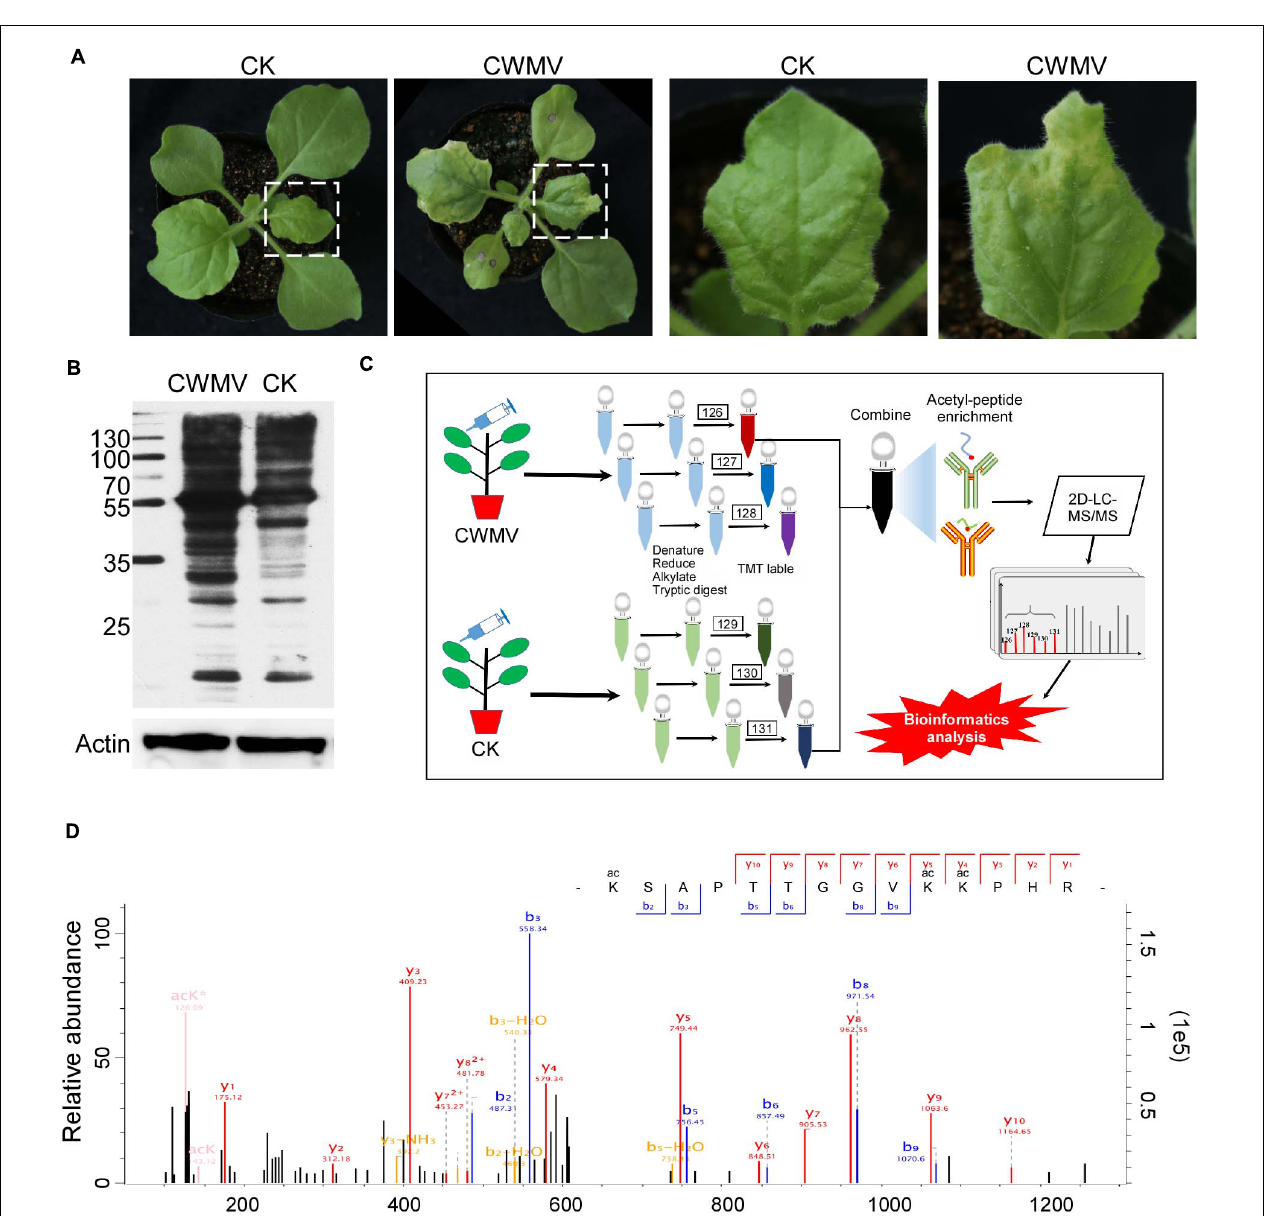
FIGURE 1 | Proteome-wide analysis of lysine acetylation peptides and proteins. (A) Photograph of Nicotiana benthamiana 14 days post-inoculation with CWMV. (B) Detection of Lys-acetylated proteins in CWMV-infected N. benthamiana leaf samples and uninfected leaf samples by western blot assays using anti-acetyl-Lys antibodies. (C) The workflow used for the Kac proteomic experiments. (D) LC-MS/MS spectra of acetyl-peptides from a upregulated chloroplastic protein named 29 kDa ribonucleoprotein B; acetyl-peptide VEVIYDK(ac)LTGR with one acetylation site at K122.